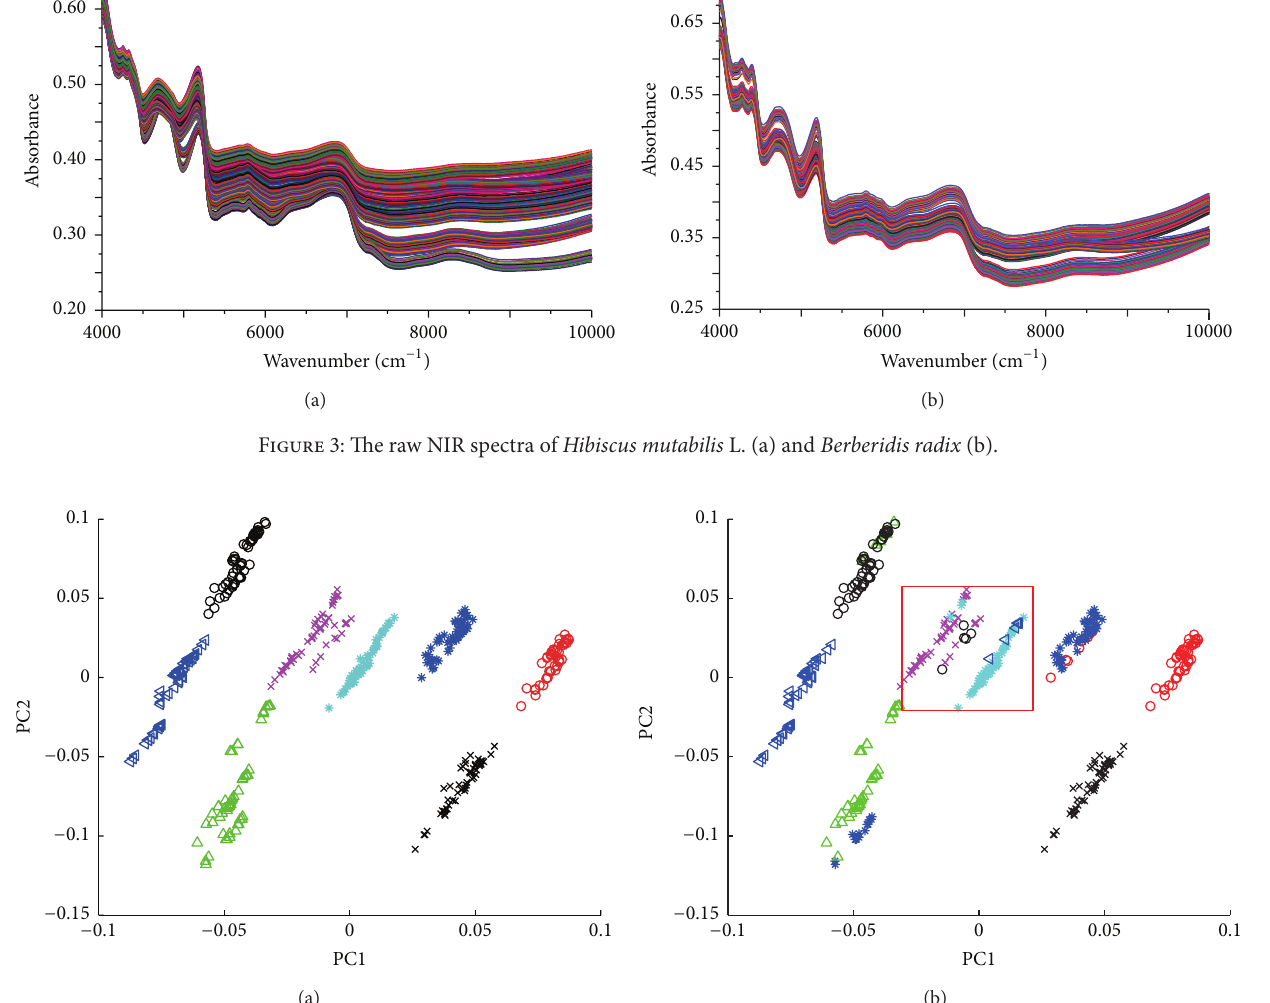
and preprocessing spectral variables of different sample